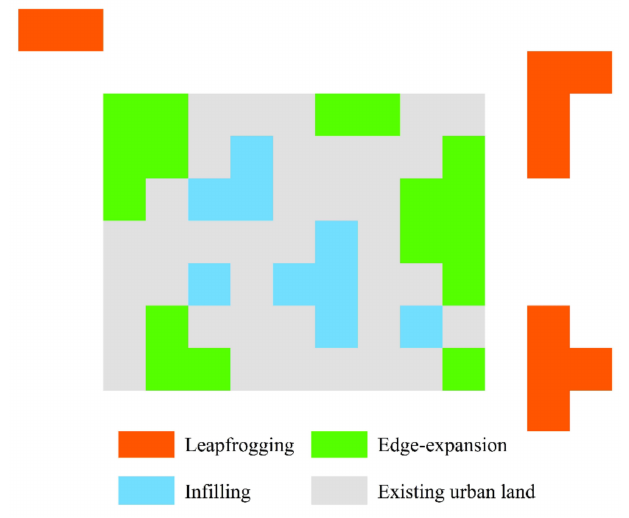
Figure 4. Existence modes of infilling, edge-expansion, and leapfrogging.